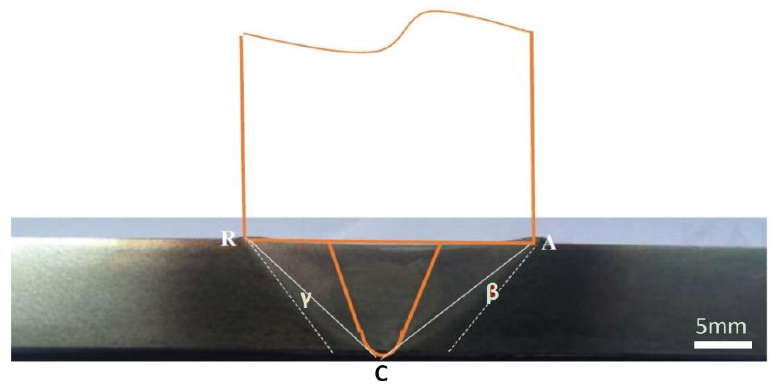
Figure 5. Schematic of FSW and affected area by shoulder and pin used in this study.